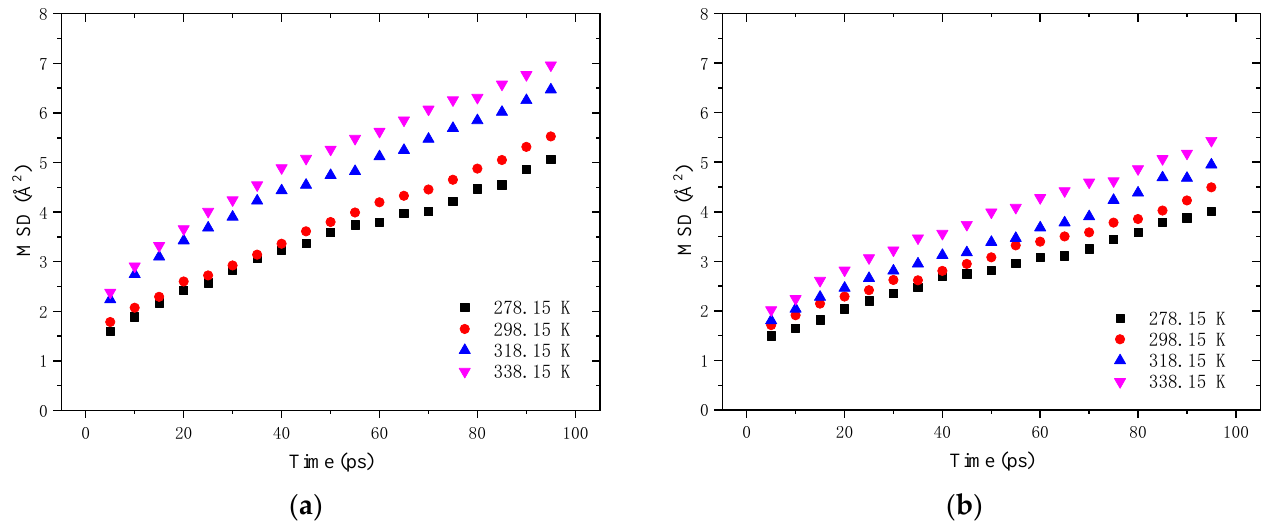
Figure 13. MSD-time curve of self-healing model of asphalt binder with 1 nm crack at the intrinsic healing stage: ( a ) neat asphalt binder; ( b ) aged asphalt binder.